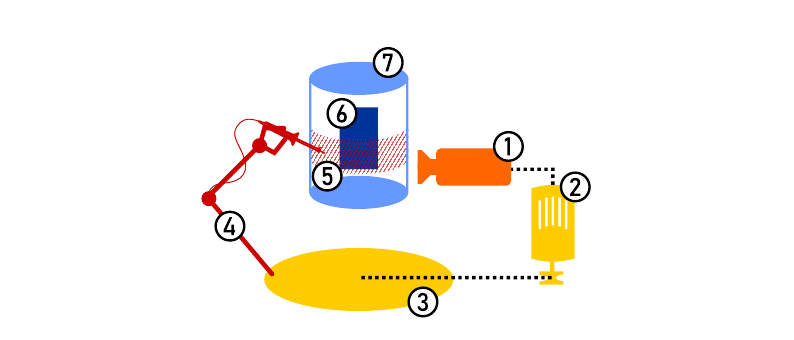
Figure 3: Schematic overview of a robotic rotating-stage attack. An optical sensor (1) observes the IHSM’s rotation and adjusts the setpoint of a servo motor (2) that rotates the attack stage (3). On the rotating attack stage, a remote-controlled manipulator (4) is mounted that deactivates the security mesh (7) and creates an opening (5).